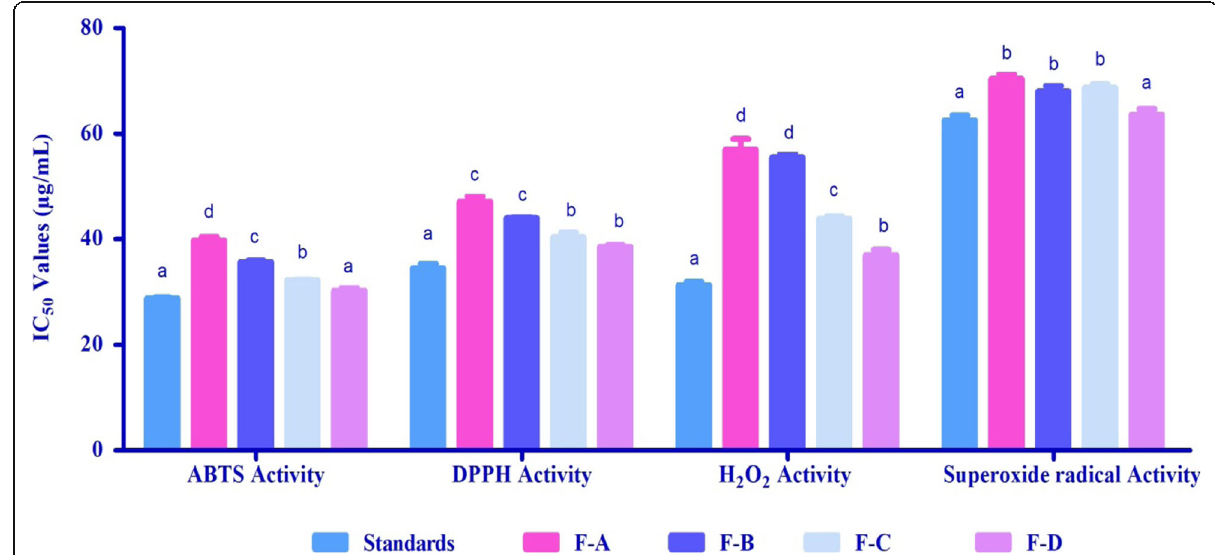
Fig. 3 IC 50 values of free radical scavenging activities of four pooled fractions of MeCV and standards. Each vertical bar represents mean ± SE for n = 3. The vertical bars having the same alphabet do not differ significantly whereas the bars having the different alphabet differ significantly at P < 0.05 (one-way ANOVA followed by Tukey ’ s post hoc